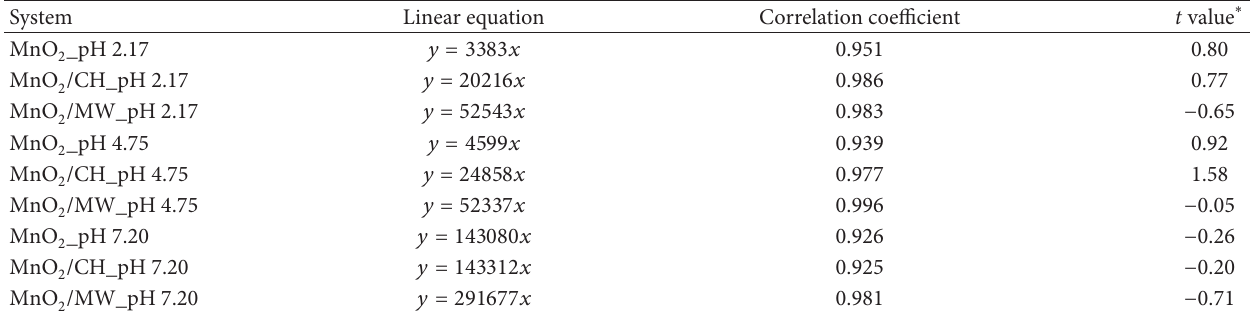
T 3: e linear equation and correlation coefficient of regression line in Figure 4. System Linear equation